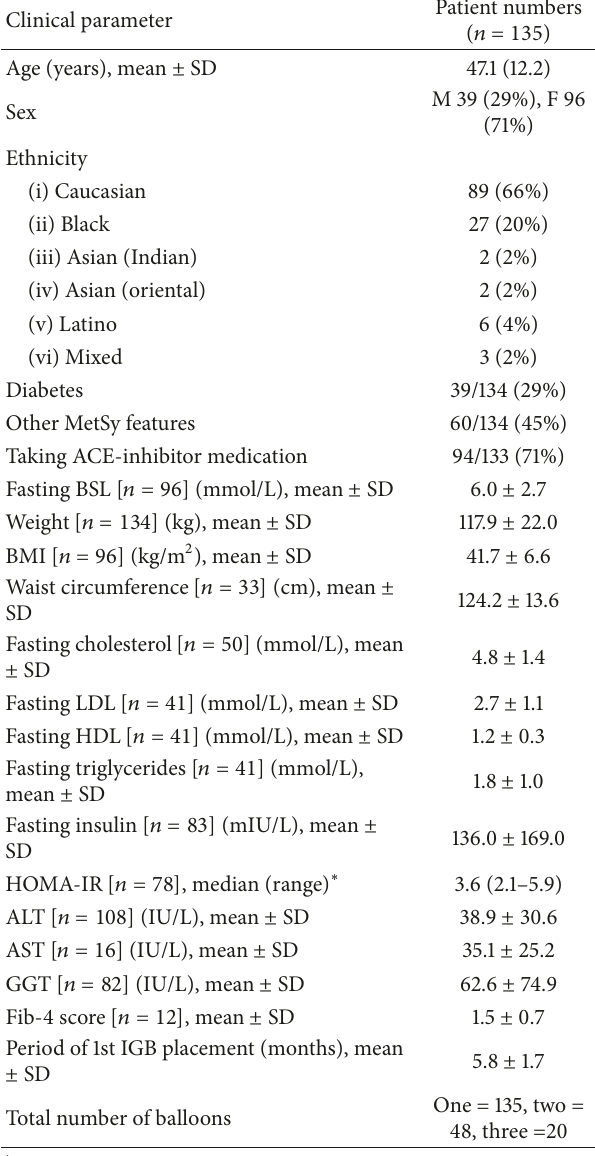
Table 1: Baseline